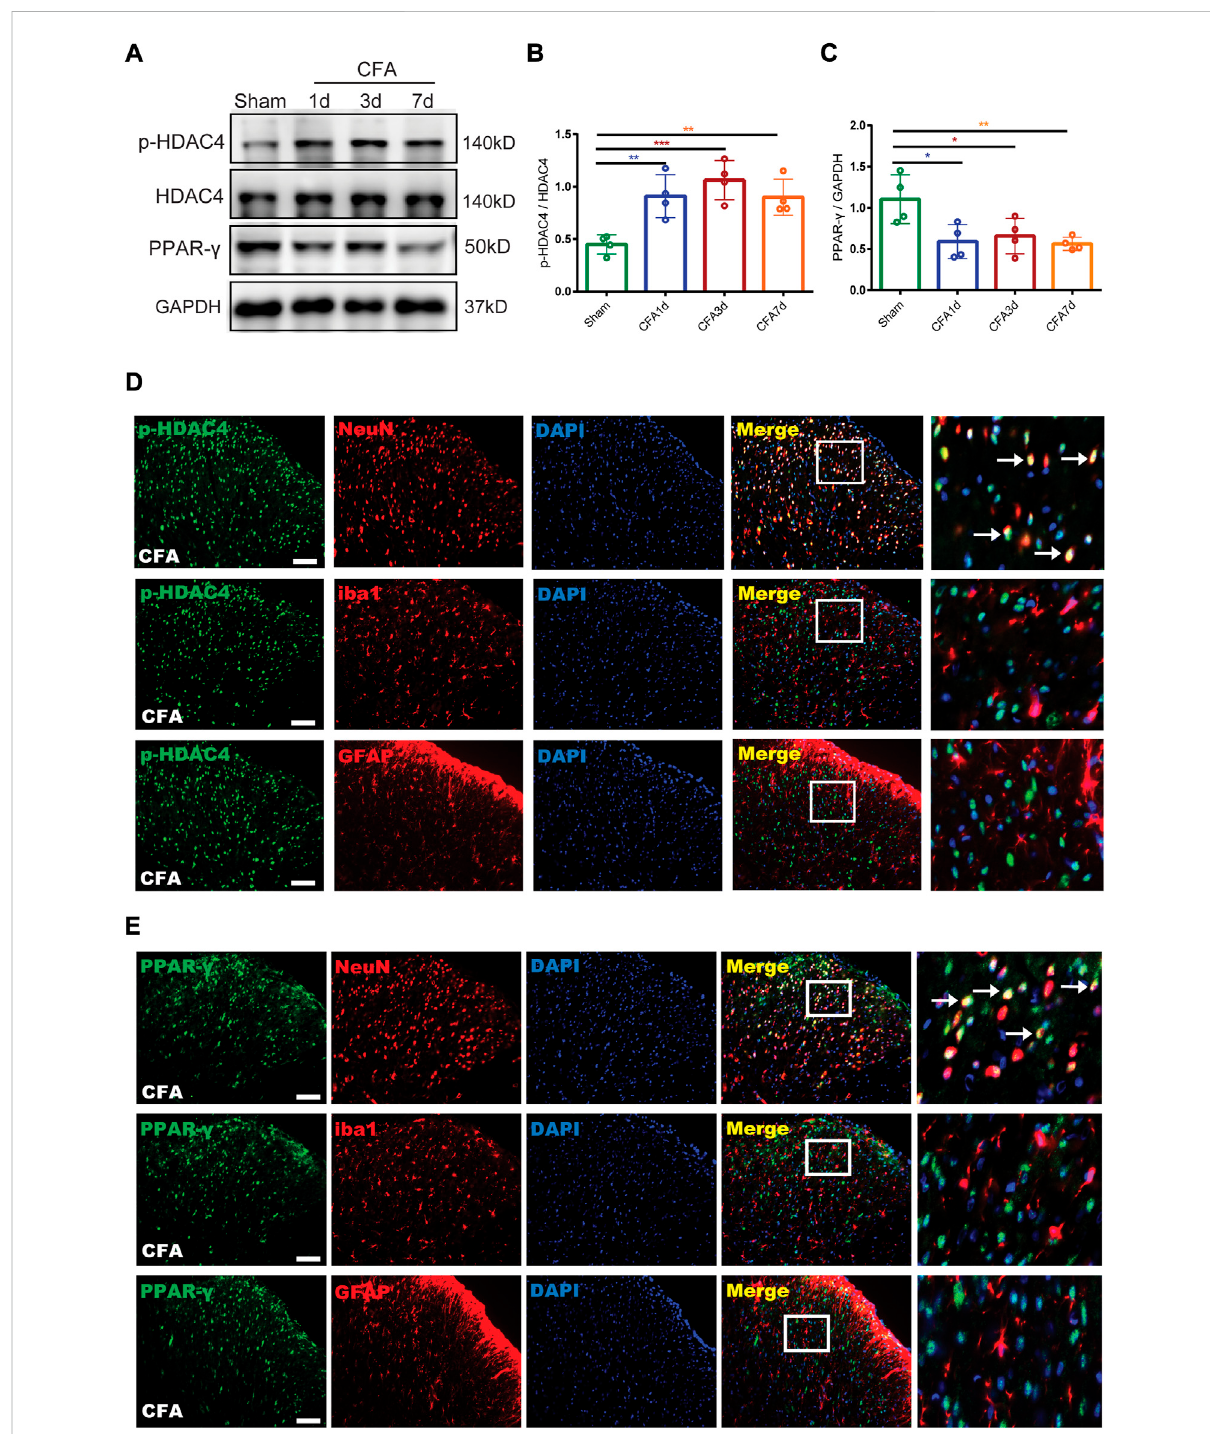
FIGURE 3 The endogenous expression and cellular localization of p-HDAC4 and PPAR- γ in the spinal cord of CFA rats. (A – C). The protein expressions of p-HDAC4 and PPAR- γ in the spinal cord of rats were detected by Western blotting. (D,E). The colocalization of p-HDAC4 and PPAR- γ with NeuN, iba1, and GFAP were detected by a double-label immuno fl uorescence assay in CFA rats. The white arrows indicate colocalization of p-HDAC4 and PPAR- γ with NeuN. Scale bar = 50 μ